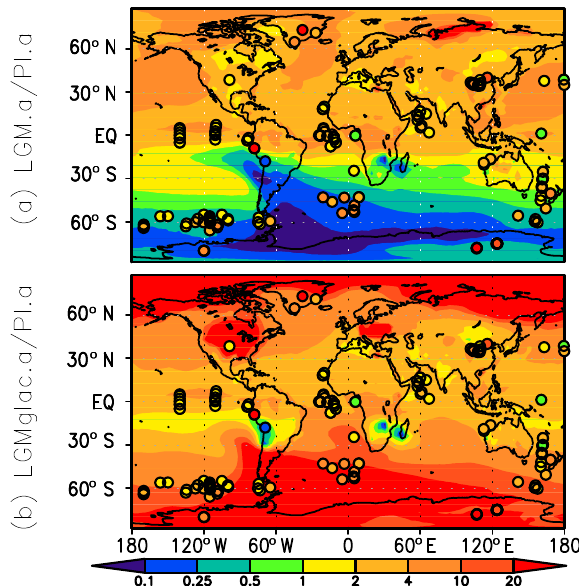
Figure 5. Model–data comparison of the ratio of dust deposi- tion flux estimated from the ice and sediment core data archives obtained from Kohfeld et al. (2013) and Albani et al. (2014): (a) LGM.a / PI.a and (b) LGMglac.a / PI.a.